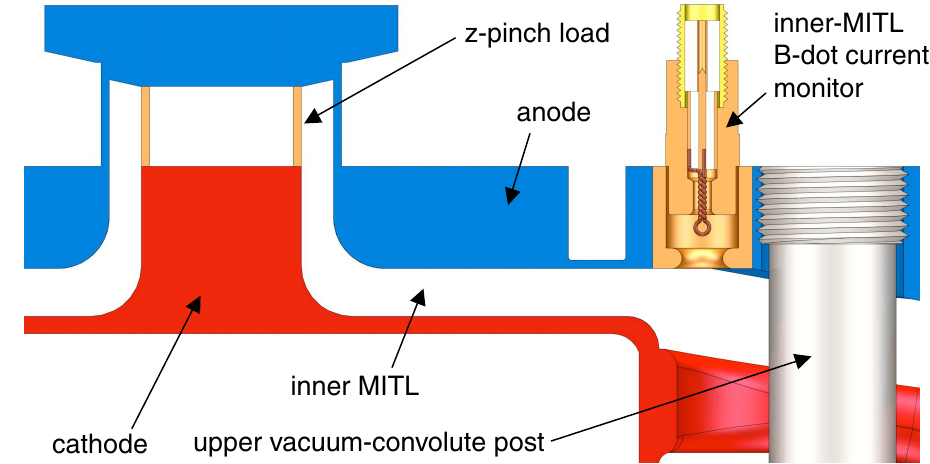
FIG. 6. (Color) Cross-sectional view of the inner-MITL B -dot current